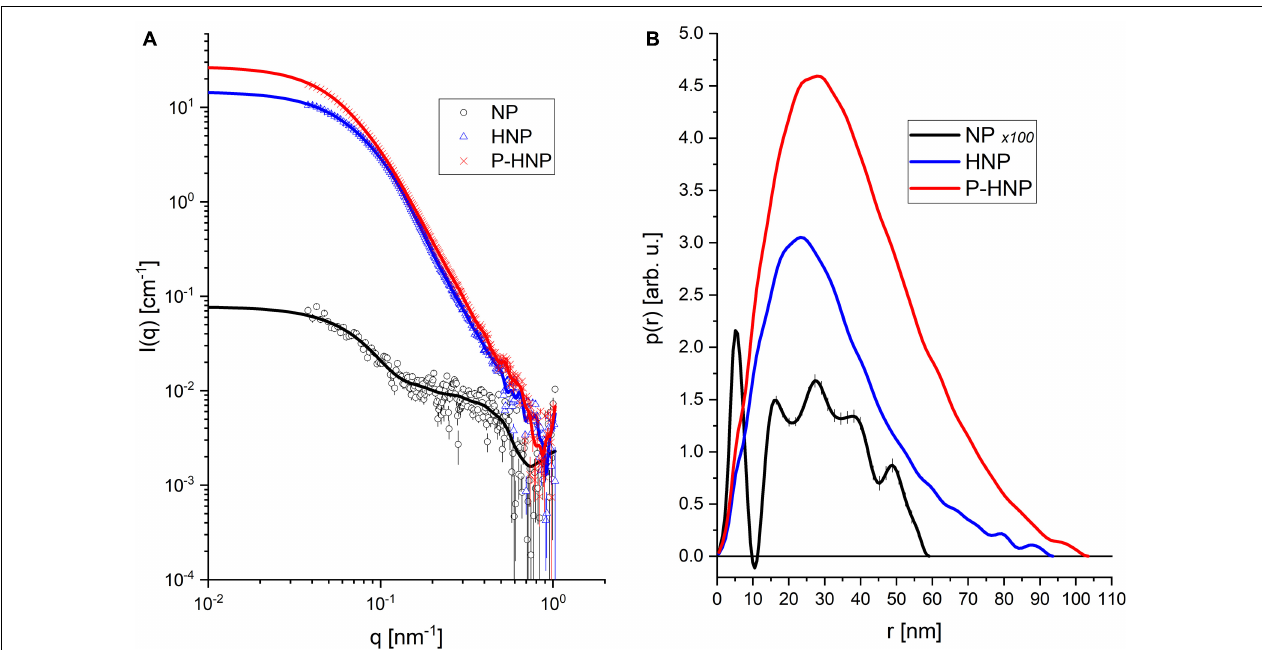
FIGURE 2 | Experimental data from SAXS and Indirect Fourier Transform (IFT) modeling. (A) Experimental data (symbols) and theoretical model (solid lines). (B) Curves of distance distribution between pairs [p(r)] obtained for each sample.